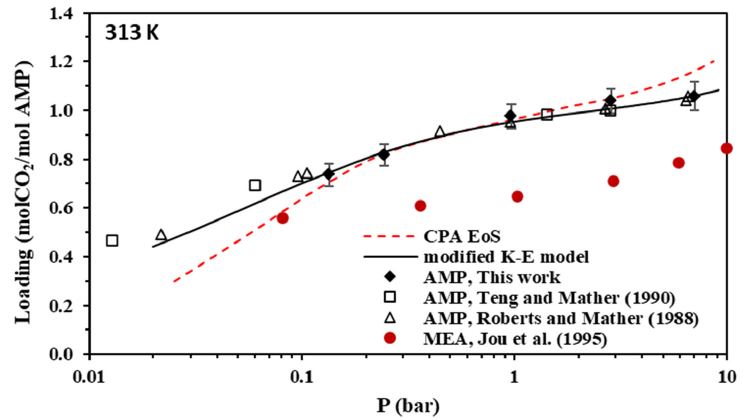
Figure 4. Solubility of CO 2 in aqueous AMP (17.7% wt.) solutions at 313 K (Data for MEA are also shown for comparison). Experimental data for AMP (points, from this work, Teng and Mather [30], and Roberts and Mather [28]), experimental data for MEA (solid circles, from Jou et al. [55]), and correlations (lines) with the CPA equation of state and the modified Kent–Eisenberg model.